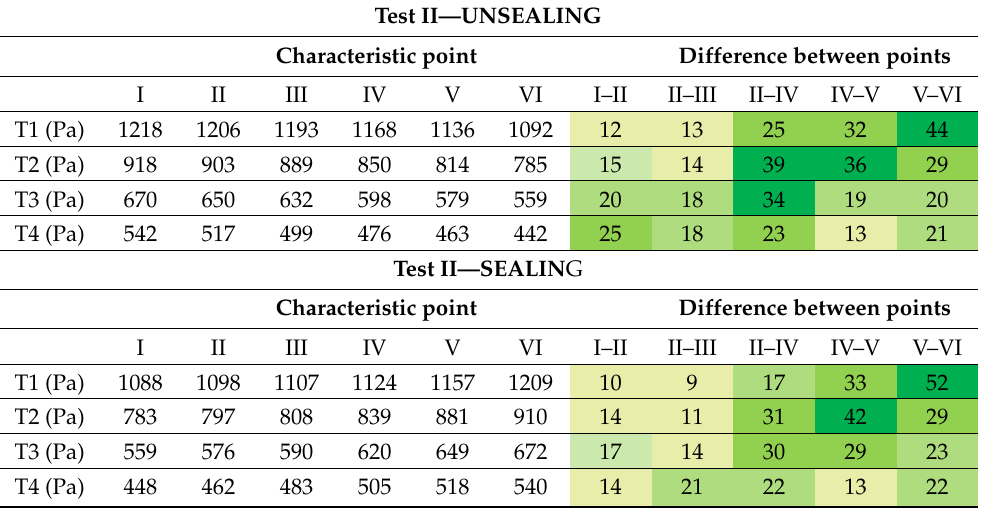
Table 2. Static pressure and static pressure differences noted during unsealing and sealing of the system (II test).